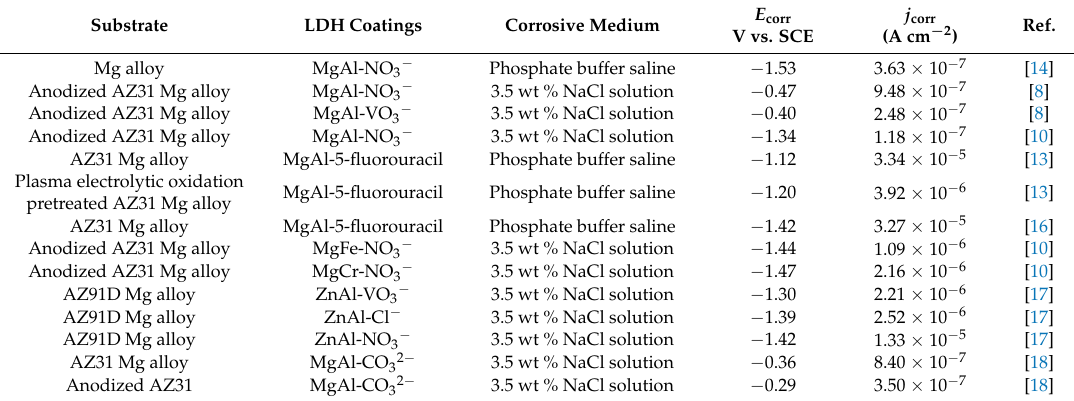
Table 1. Corrosion inhibition of different layered double hydroxide (LDH) coatings on Mg alloy from most recent published